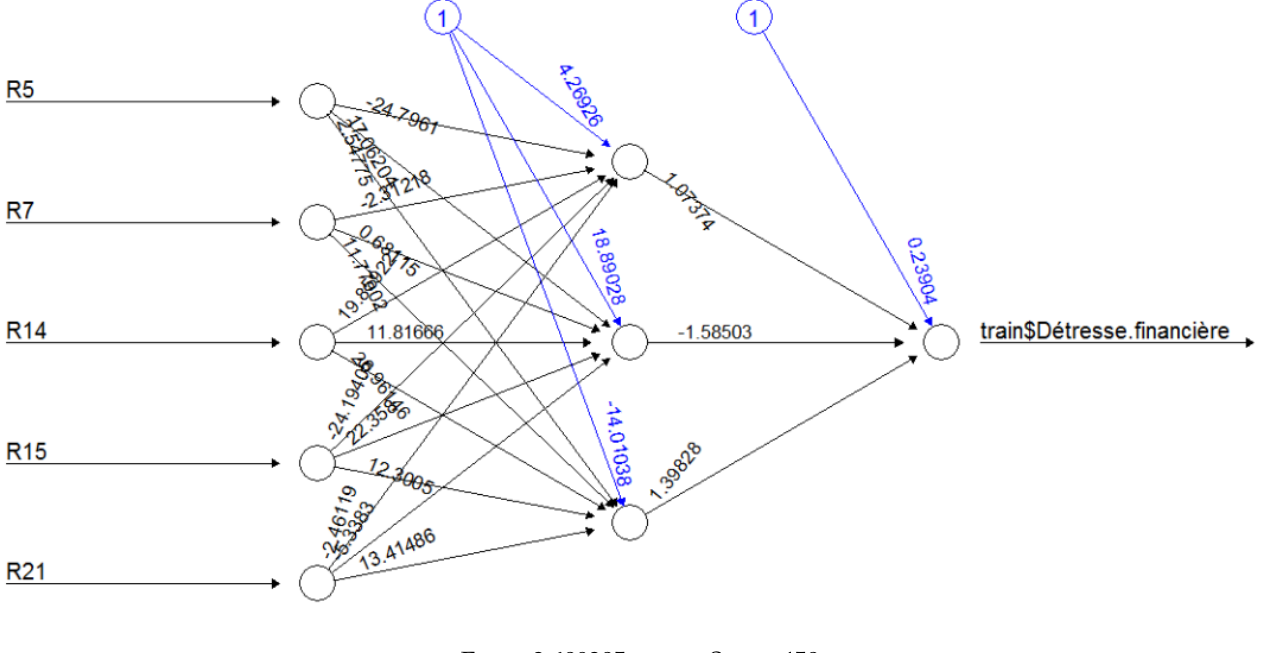
Figure A1. Neural networks model for stepwise selection technique, year